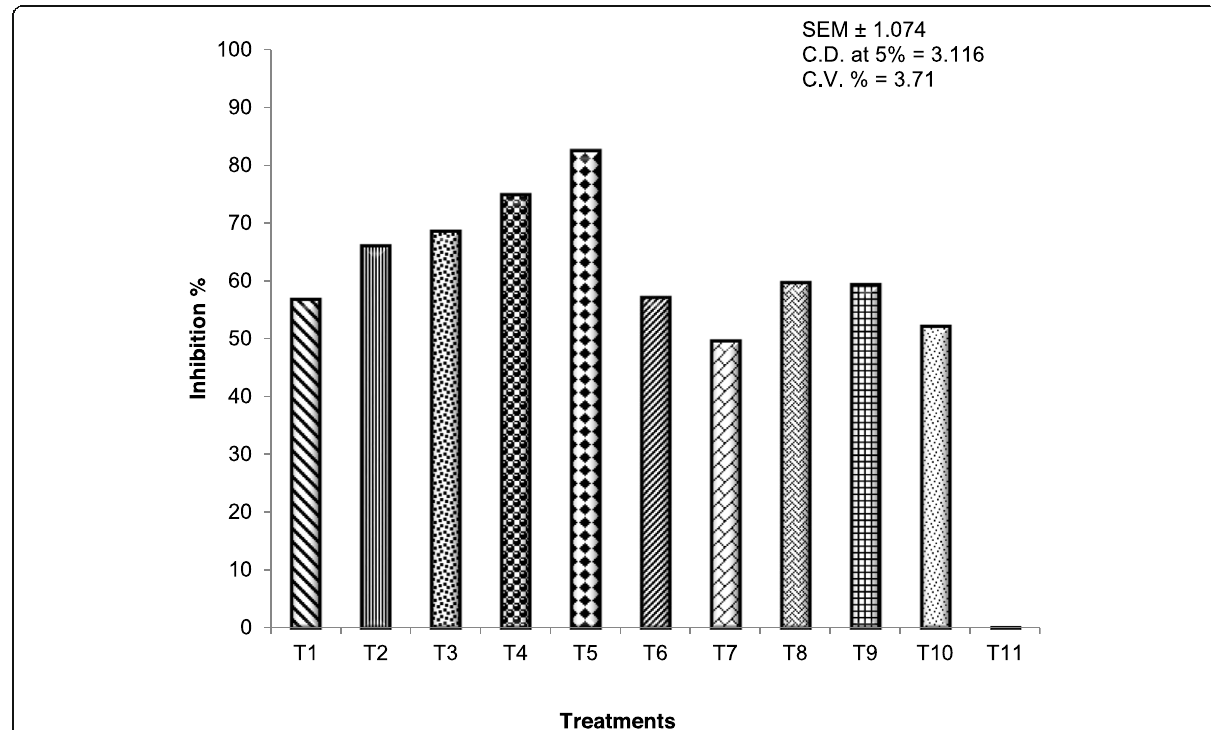
Fig. 2 Percent growth inhibition of Fusarium oxysporum f. sp. cumini ( Foc ) in in vitro antagonism with Pseudomonas fluorescens ( Pf ) isolates at 6 days after inoculation (DAI). (T1 = Pf -1 × Foc ; T2 = Pf -2 × Foc ; T3 = Pf -3 × Foc ; T4 = Pf -4 × Foc ; T5 = Pf -5 × Foc ; T6 = Pf -6 × Foc ; T7 = Pf -7 × Foc ; T8 = Pf -8 × Foc ; T9 = Pf -9 × Foc ; T10 = Pf -10 × Foc ; T11 = Control − Foc